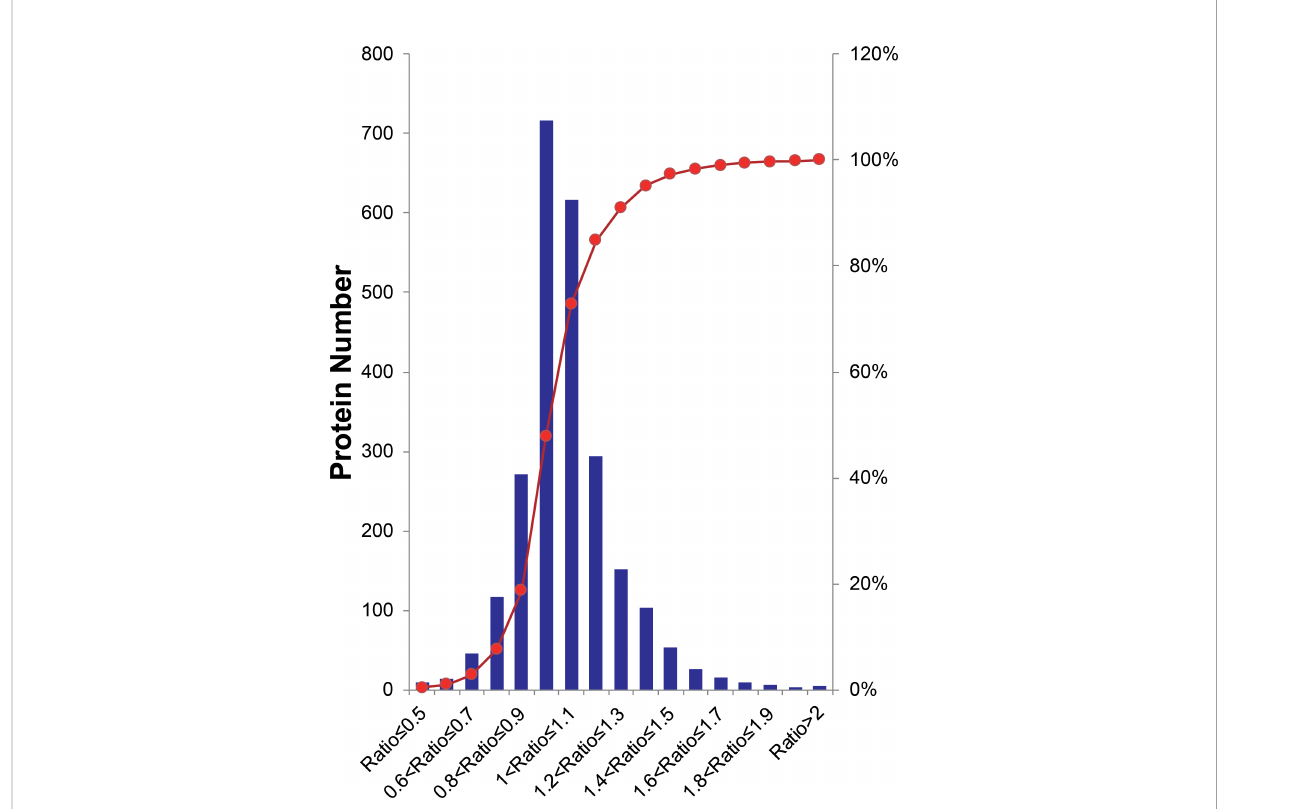
FIGURE 2 Histogram distribution of expression ratios of quanti fi ed proteins. The Red line indicates the cumulative percentage of